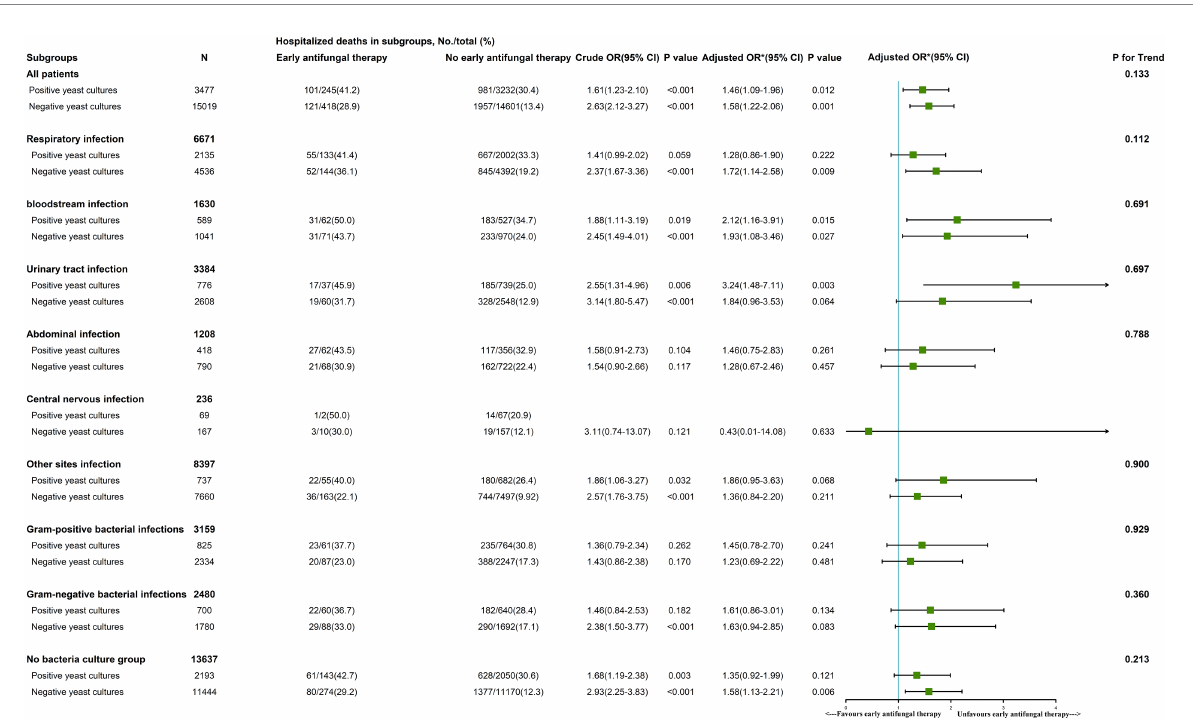
FIGURE 3 The role of early antifungal therapy in subgroups of patients with sepsis. *We adjusted age, gender, ethnicity, insurance, weight, source of admission, history of disease, SOFA score, vital signs, laboratory outcomes, in-hospital management and antifungal agents. In the last column, p for interaction was 0.133, indicating that there was no significant difference in the relationship between early antifungal therapy and hospital death between positive yeast cultural and negative yeast cultural. That is to say, the previous differences of 1.46 and 1.58 in OR were not significant, and the relationship between early antifungal therapy and hospital death could not be considered to be different in patients between positive yeast cultural and negative yeast cultural. Other parameters like respiratory infection, urinary tract infection, bloodstream infection, abdominal infection, other sites infection, gram-positive bacterial infections, gram-negative bacterial infections and no bacteria culture group are interpreted similarly to all patients